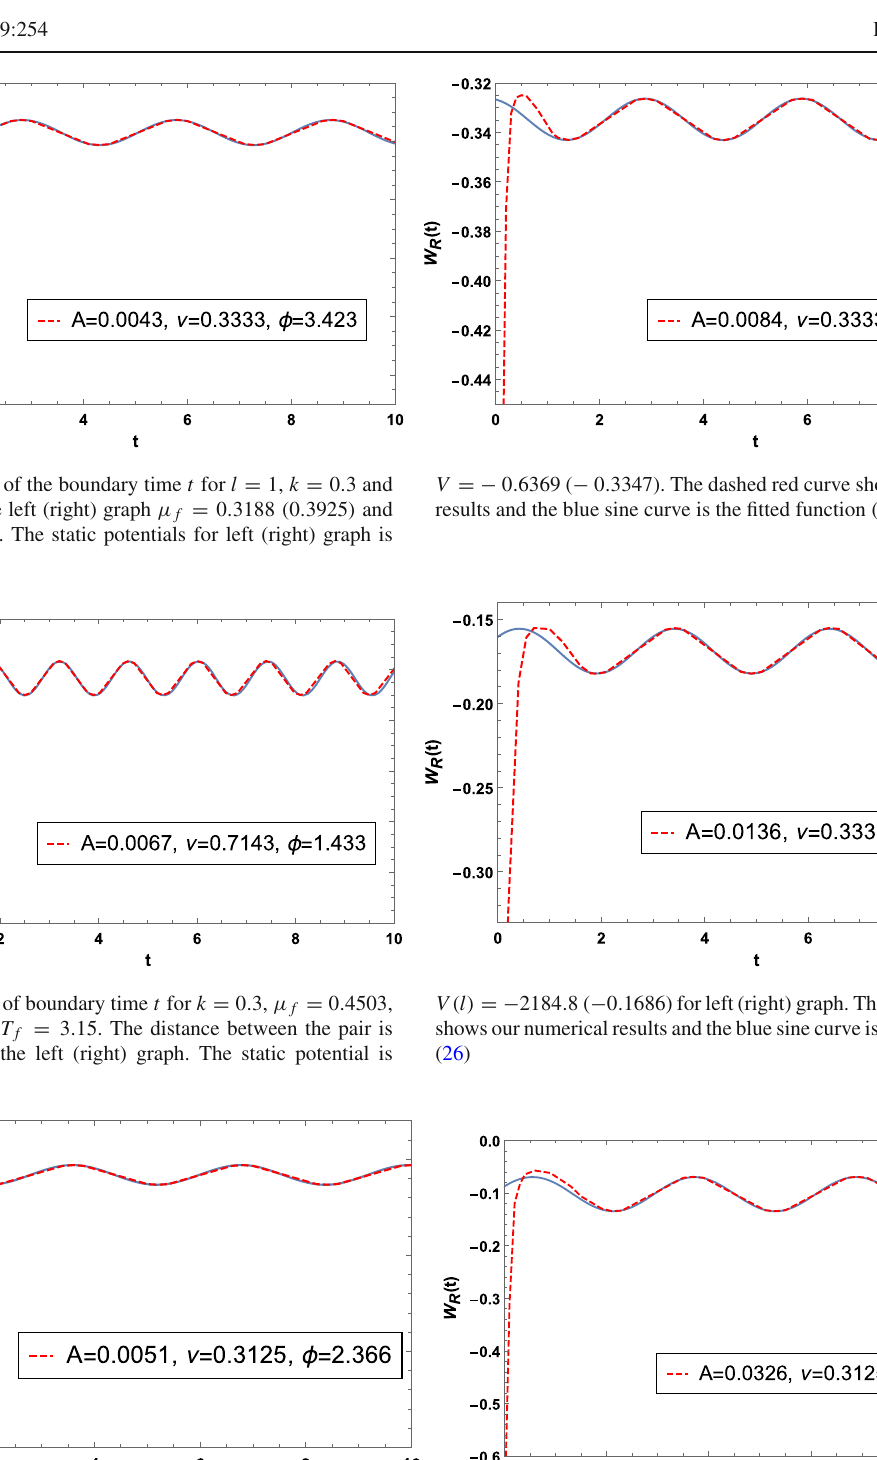
V = − 1 . 4081 ( − 0 . 1017) respectively. The dashed red curve shows our = 0 . 0134 ( 0 . 0220 ) and numerical results and the blue sine curve is the fitted function f